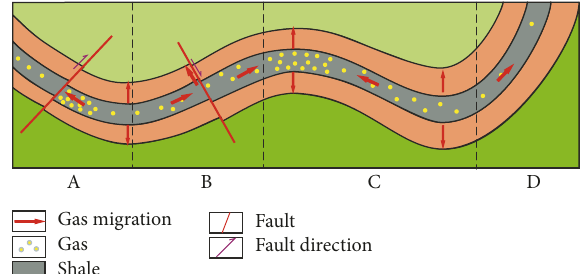
Figure 6: Shale gas accumulation pattern under complex tectonic